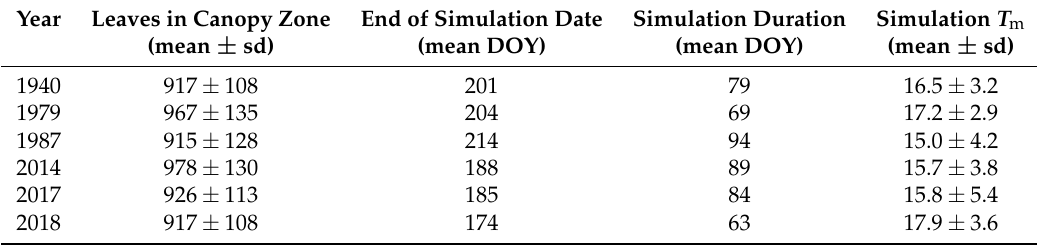
Table 3. Average number of leaves in canopy zone ( ∆ y = 0.9m) per year with corresponding